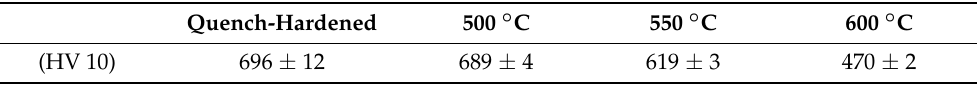
Table 5. Vickers hardness of the heat-treated X37CrMoV5-1 PBF-EB